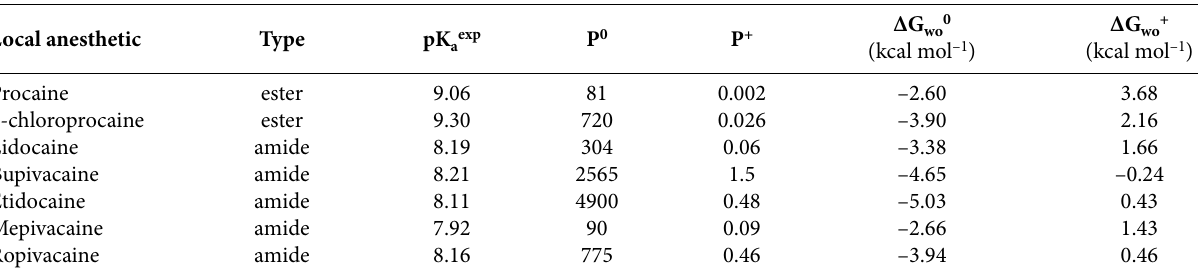
Table 1. Experimental pK a (acid dissociation constant) values, n-octanol/water partition coefficients and calculated free energy differences for studied local anesthetics . pK aexp values refer to the experimentally calculated acid dissociation constants and were determined by the spectropho- tometrical method. All experiments were performed at 25 °C. P 0 is the n-octanol/water partition coefficient for the neutral form of local anesthetic, P + is the protonated form. ΔG wo0 refers to free energy for transfer of unprotonated local anesthetics from water to n-octanol, while ΔG wo+ is the corresponding value for protonated